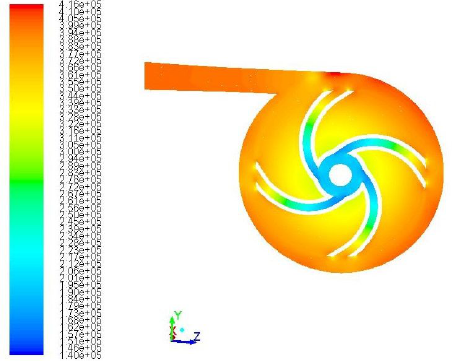
Figure 17: Static pressure distribution [Pa] in Impeller